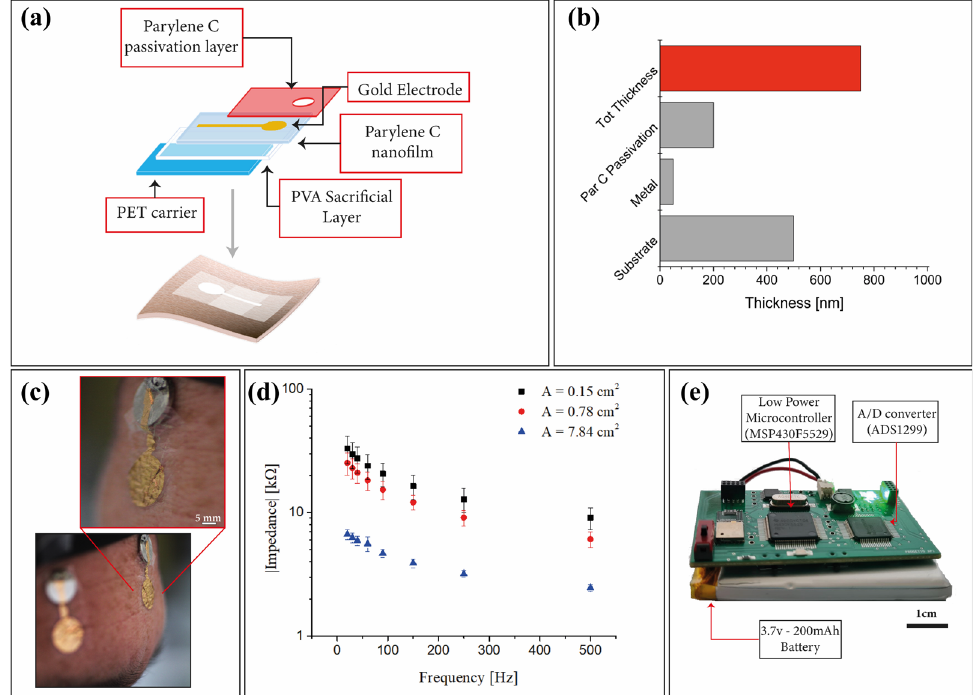
Figure 1. ( a ) Fabrication process flow where all the different layers are highlighted. ( b ) Average thickness of the proposed tattoo-electrodes. ( c ) Ultra-conformable Parylene C tattoo-electrodes applied on the forehead and positioned on a 1 cm metal plate for the signal acquisition. ( d ) Average electrode-skin impedance evaluated for three different contact areas. ( e ) Microcontroller-based custom PCB.